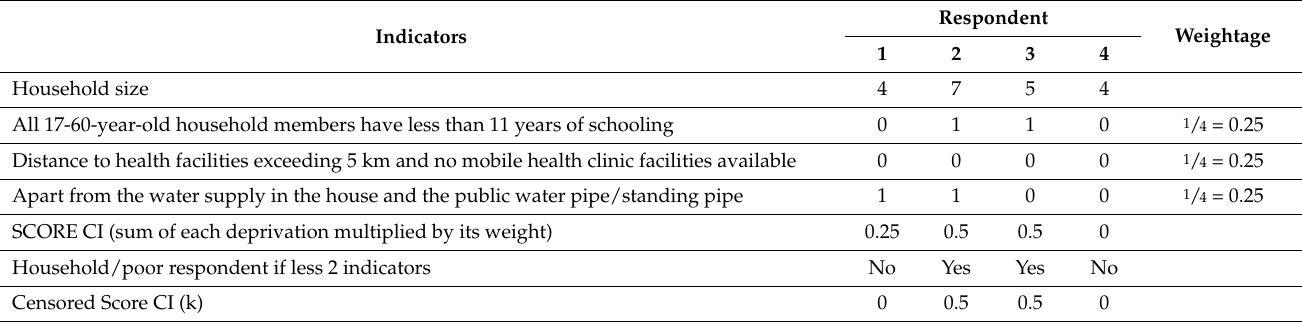
Table 1. Multidimensional Poverty Index (MPI) Calculation